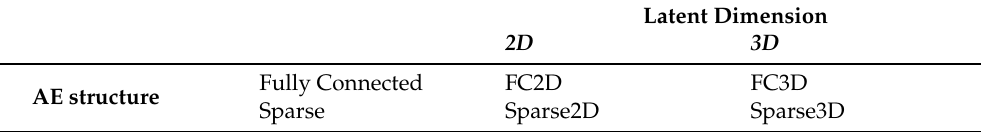
Table 1. The combinations of the two considered AE types and the two latent